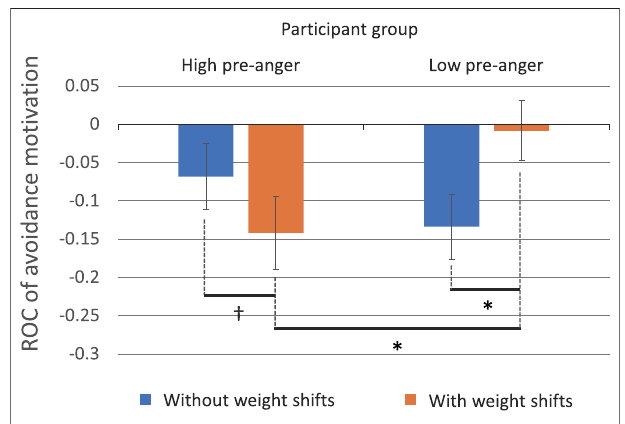
FIGURE 8 | Marginal means of the rate of change (ROC) of avoidance